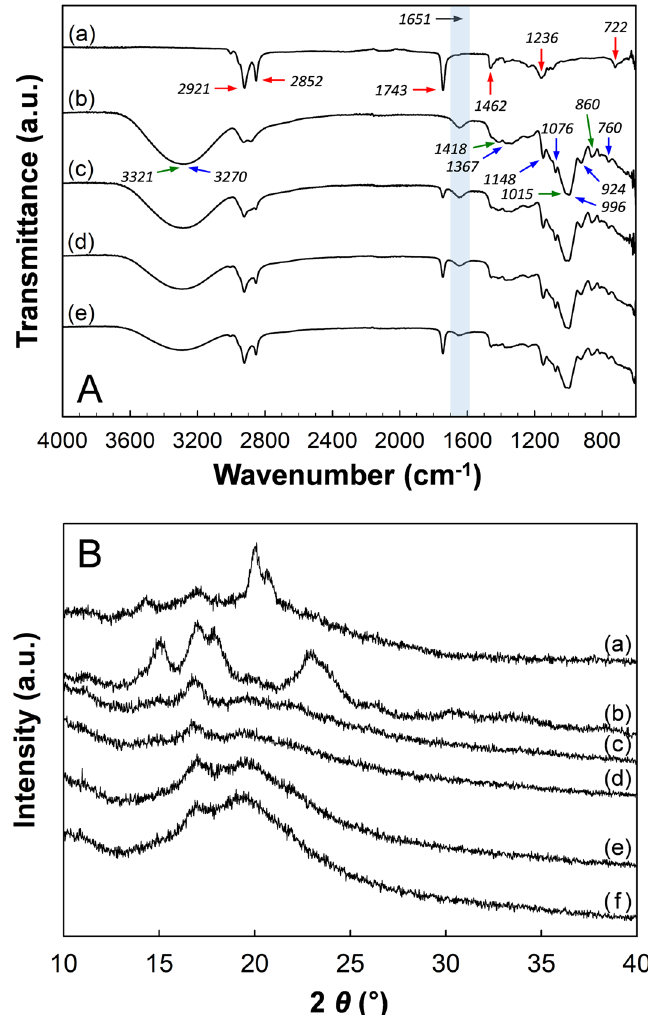
Figure 3. ( A ) FT-IR spectra of ( a ) SSO, (b) GG/MBS film, ( c ) 0.5%SSO/GG/MBS film, ( d ) 1%SSO/GG/MBS film, and ( e ) 2% SSO/GG/MBS film. Peaks marked with red, blue, and green arrows derived SSO, GG, and MBS, respectively; ( B ) XRD patterns of ( a ) GG granules, ( b ) MBS granules, ( c ) GG/MBS film, ( d ) 0.5% SSO/GG/MBS film, ( e ) 1% SSO/GG/MBS film, and ( f ) 2% SSO/GG/MBS film. GG guar gum, MBS mung bean starch, SSO sunflower seed